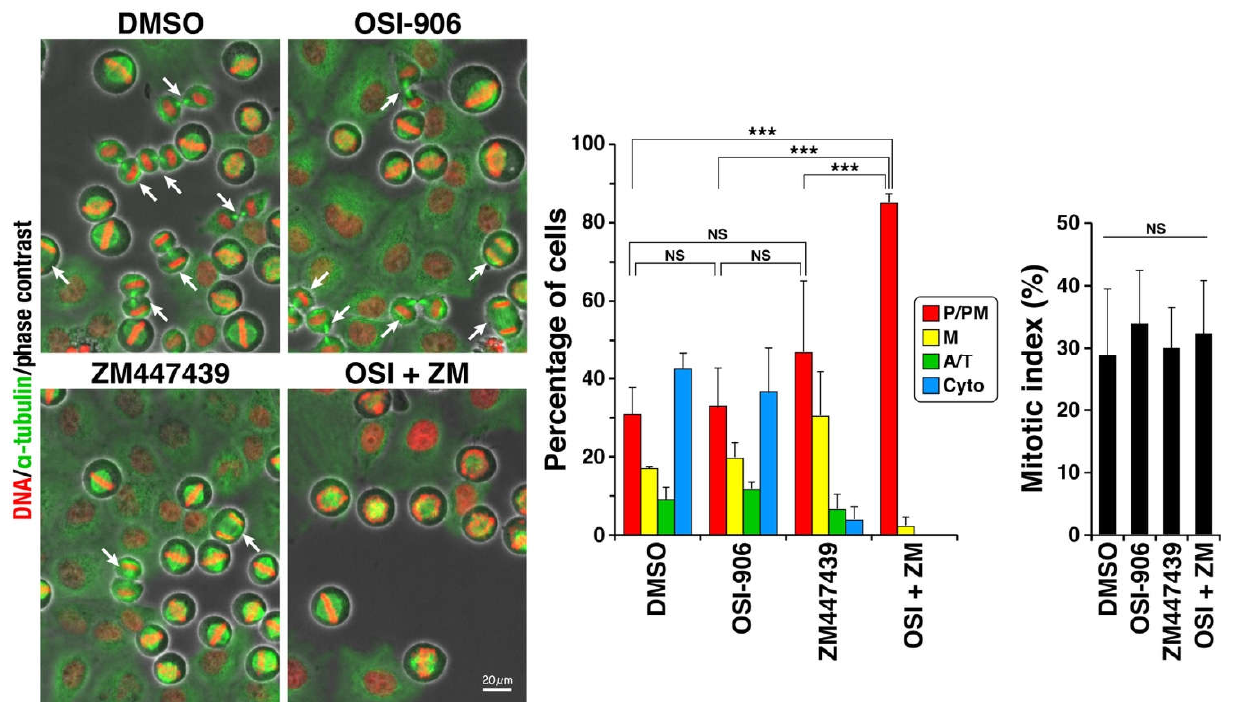
Figure 3. Combination of OSI-906 and ZM447439 causes severe defect in chromosome alignment. HeLa S3 cells were treated with 6 µM RO-3306 for 20 h, released by washing out this drug, and then cultured without RO-3306. After 60-min culture, the cells were fixed and stained for α-tubulin and DNA. Based on morphologies of spindle and chromosomes, mitotic cells were classified into four groups: prophase/prometaphase (P/PM, red), metaphase (M, yellow), anaphase/telophase (A/T, green), and cytokinesis (Cyto, blue). Cells were treated with 3 µM OSI-906, 1 µM ZM447439, or their combination (OSI + ZM) for 1 h at the end of the RO-3306 treatment and were continuously treated during the 60-minute release. Dimethyl sulfoxide was used as solvent control (DMSO). Representative images are shown. Arrows indicate cells after the onset of anaphase. The average value of each group and the mitotic index, a ratio of mitotic cells among total cell numbers, were calculated from three independent experiments (n > 222 in each experiment) and expressed as mean ± SD. p -values were calculated using Tukey’s multiple comparison test. *** p < 0.001. NS, not significant.